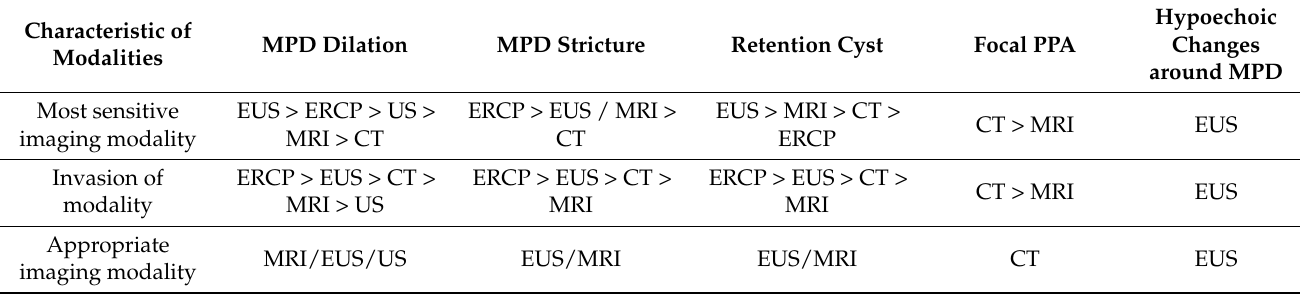
Table 3. Appropriate imaging modalities for detecting indirect imaging findings associated with high-grade pancreatic intra-epithelial